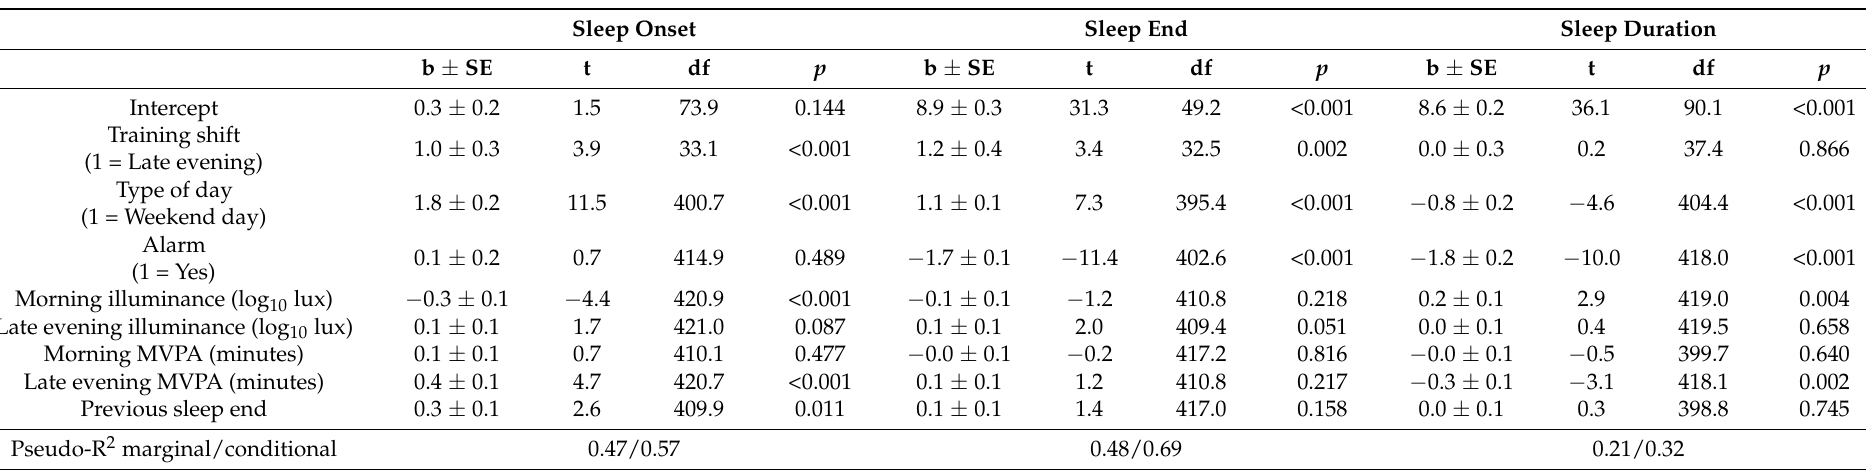
Table A2. Mixed-effects linear regressions for estimating sleep parameters adjusted for the previous sleep end (421